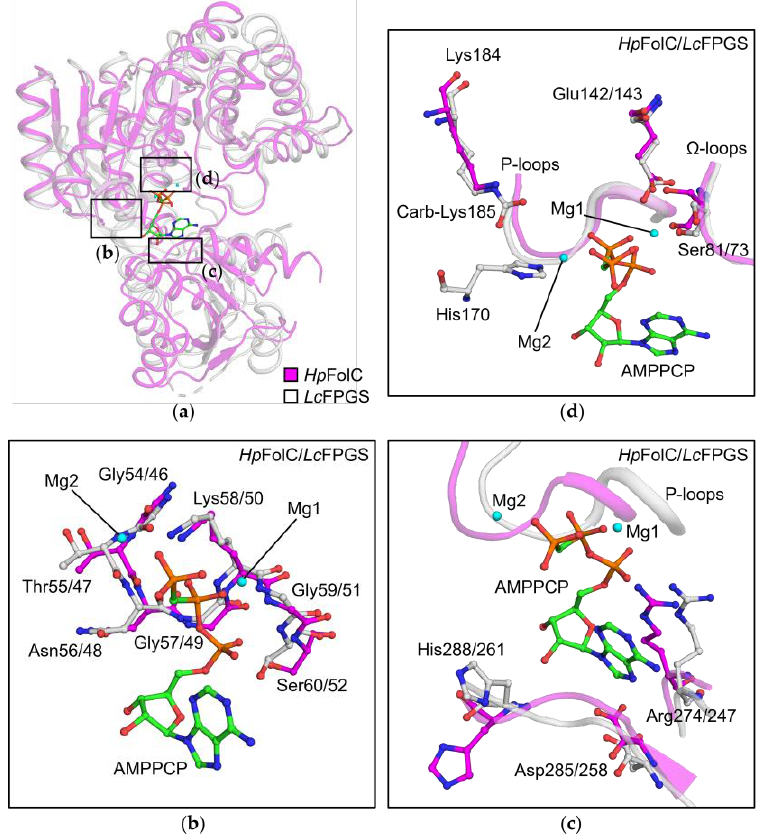
Figure 4. ATP-binding mode of Hp FolC. ( a , top left) The structures of apo- Hp FolC and L. casei FPGS ( Lc FPGS) in complex with an AMPPCP (PDB code: 1JBV) are superposed. Hp FolC and Lc FPGS are shown in magenta and white cartoon representations, respectively. The AMPPCP molecule is shown with green sticks. Nitrogen, oxygen, phosphorus, and magnesium atoms are colored in blue, red, orange, and cyan, respectively. ( b , bottom left) The P-loop residues of Lc FPGS and Hp FolC are shown with white and magenta sticks, respectively. ( c , bottom right) Non-P-loop residues of Lc FPGS interacting with the AMPPCP molecule and overlapped Hp FolC residues are shown with white and magenta sticks, respectively. ( d , top right) Residues of Lc FPGS coordinating Mg1 / Mg2 and overlapped Hp FolC residues are shown with white and magenta, respectively.